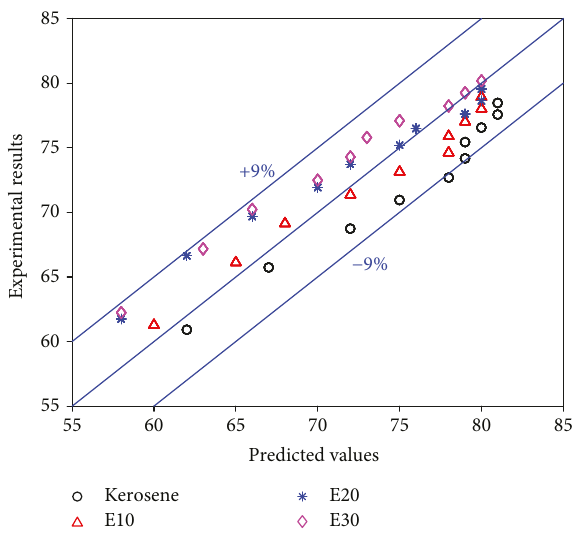
Figure 6: Variation of the discharge coe ffi cient of the pressure-swirl nozzle with injection